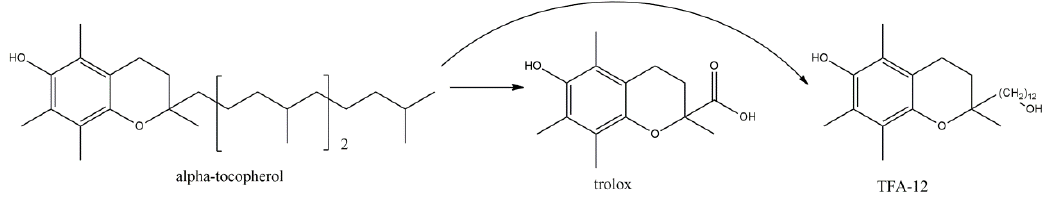
Figure 5. alpha-tocopherol, trolox (a widely used in medicinal chemistry synthetic derivative) and